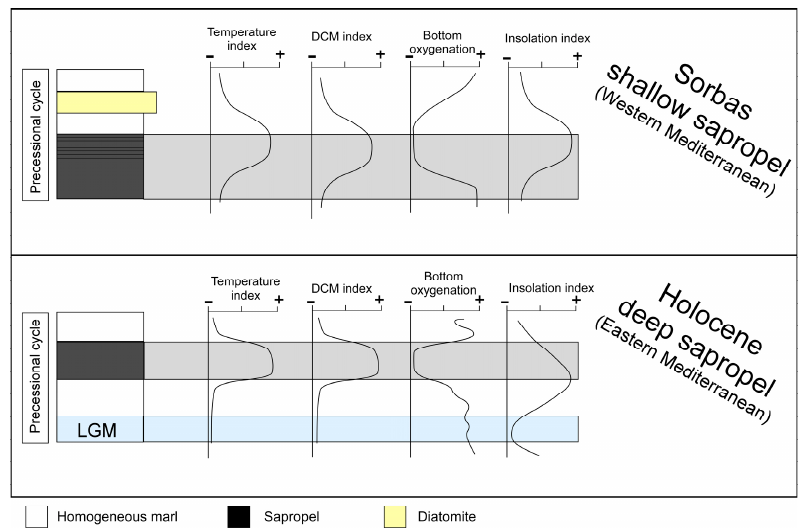
Figure 7. Comparison between the Holocene deep sapropel deposited in the eastern Mediterranean with the shallow Messinian sapropel deposited in the Sorbas Basin. The light blue rectangle at the bottom refers to the Last Glacial Maximum [LGM]. The warm/oligotrophic, cold/eutrophic, DCM, and the oxygen data are from [20,49,60,61]. These indexes were based on the distribution of planktic foraminifera and nannofossils (warm/oligotrophic, cold/eutrophic and DCM index) and on benthic foraminifera (oxygen concentration) (for more detail see the Sections 3.1 and 3.3).